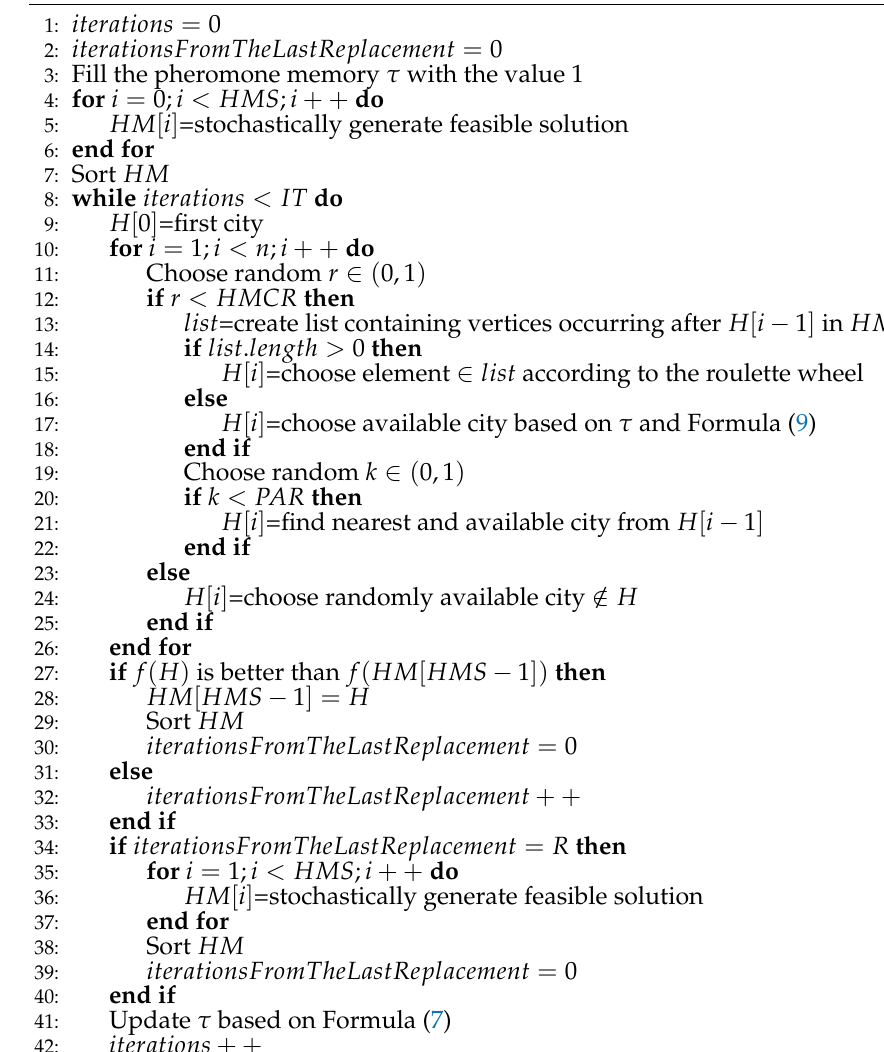
Algorithm 2 The Pheromone-based Harmony Search for ATSP